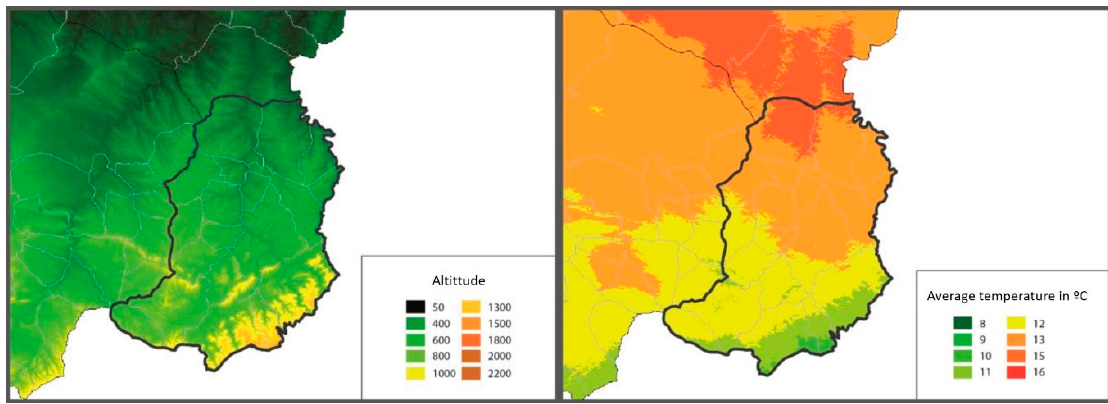
Figure 2. Maps of the Matarraña region, where the altitude (left) and average temperature in °C (right) are shown (http://www.opengis.uab.es/wms/aragon/. Access 15 May 2021).